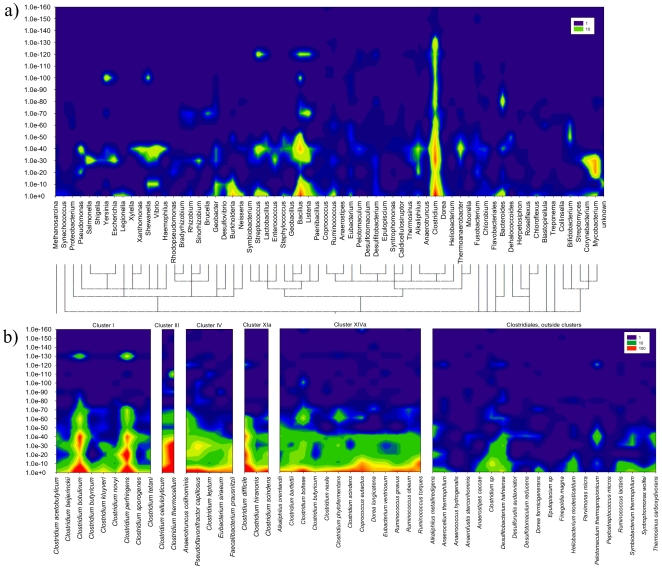
BLASTP result distribution across fosmids 7–14 and 7–25.a) The X-axis indicates genera with at least 10 BLASTP hits throughout the ORFeome of the analyzed fosmids. Using a previously published approach [33] the organism distribution on a genus level was identified for each coding gene, e-values were grouped into ranges, and threshold levels were defined for minimum overall frequency. Genera are phylogenetically sorted. The Y-axis indicates respective e-value ranges. The frequency of hits for each genus in each e-value range (log scale) is shown by color coding and corresponding values are indicated in the figure. All BLASTP hits per genus per ORF were accepted. b) Same as a), except that custom databases of species from phylogenetically defined Clostridium clusters were used.